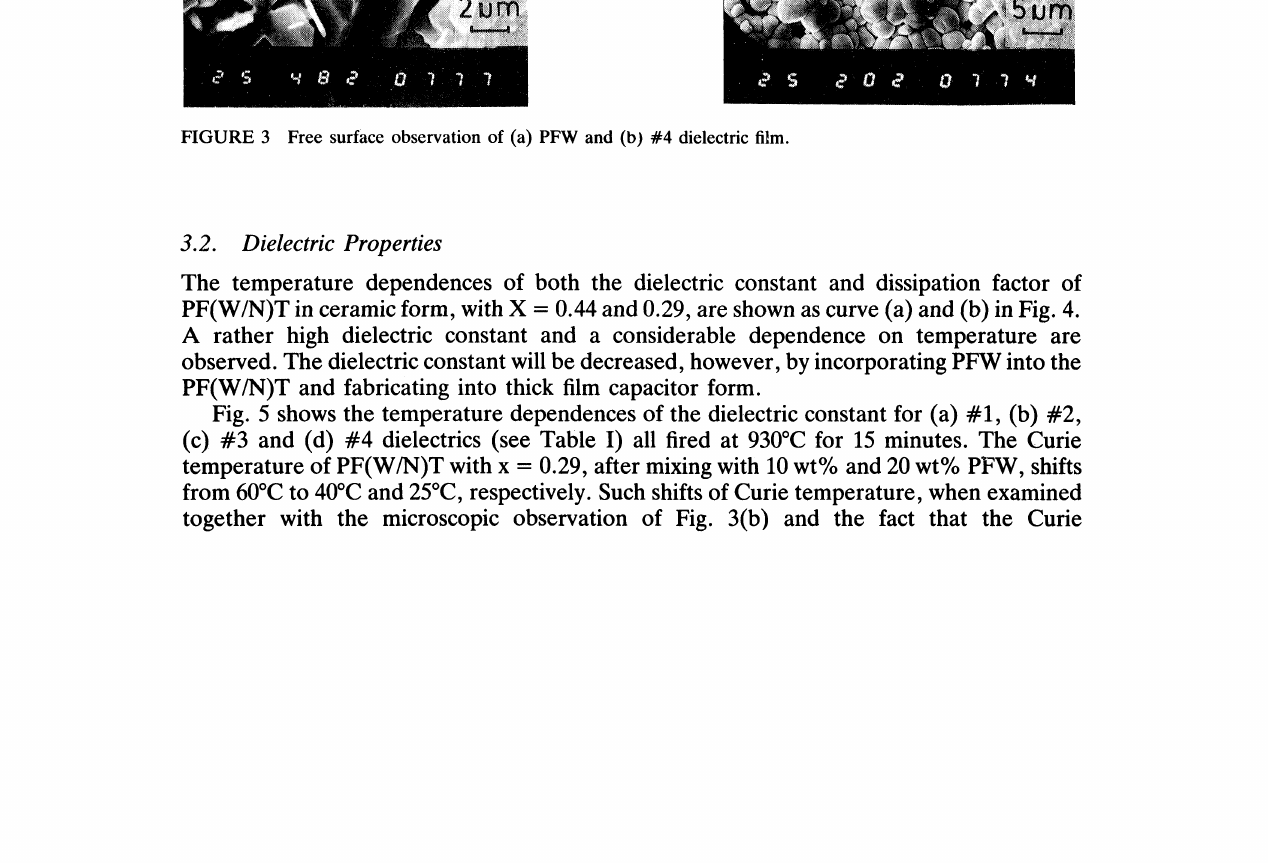
FIGURE 3 Free surface observation of (a) PFW and (b) #4 dielectric